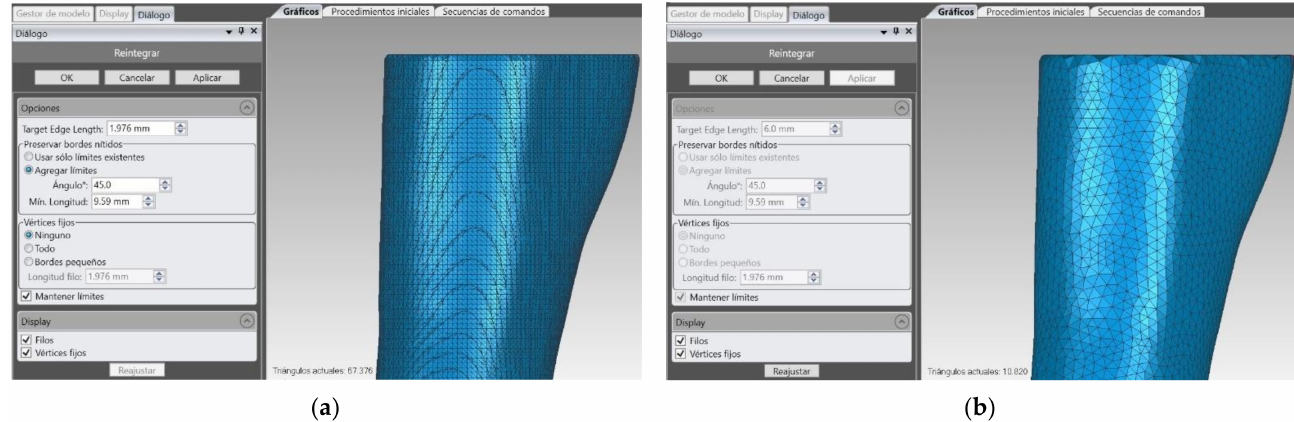
Figure 5. Original mesh ( a ) and reduced mesh ( b